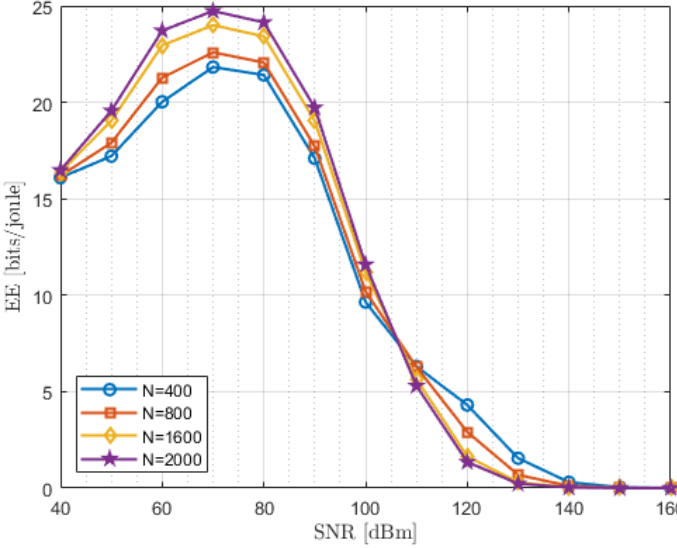
Figure 7. EE versus SNR with varying